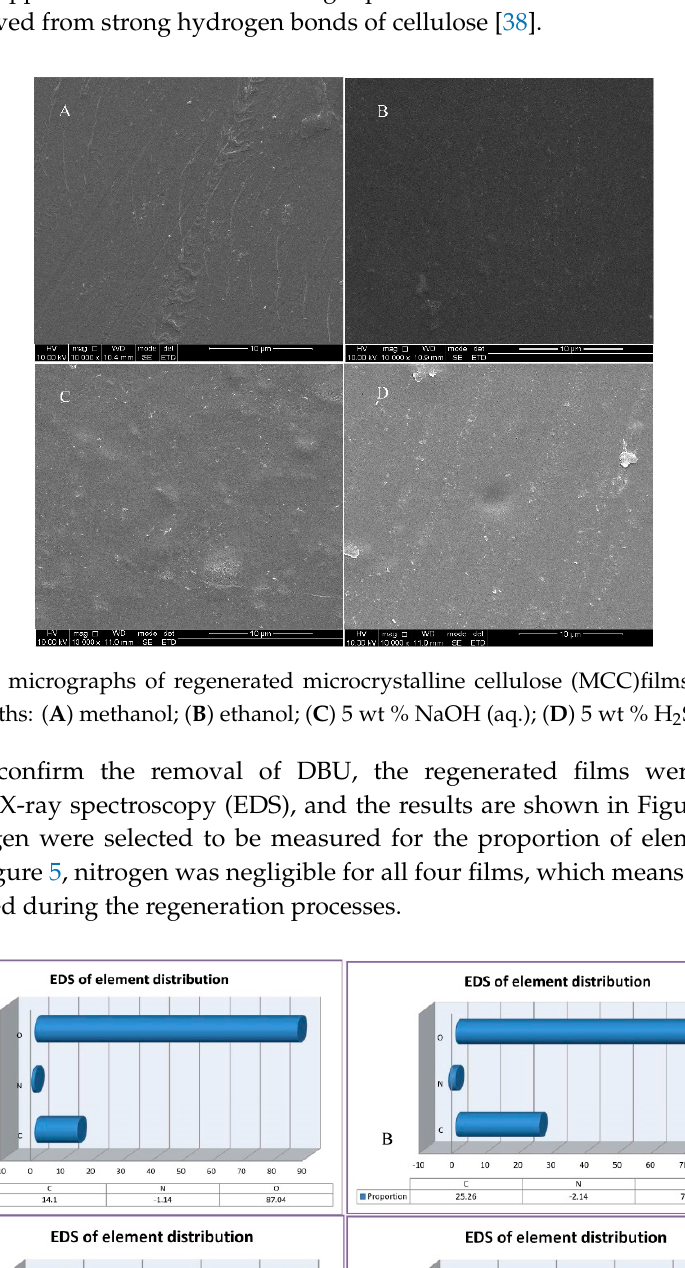
Figure 4. SEM micrographs of regenerated microcrystalline cellulose (MCC)films from different regeneration baths: ( A ) methanol; ( B ) ethanol; ( C ) 5 wt % NaOH (aq.); ( D ) 5 wt % H 2 SO 4 (aq.).